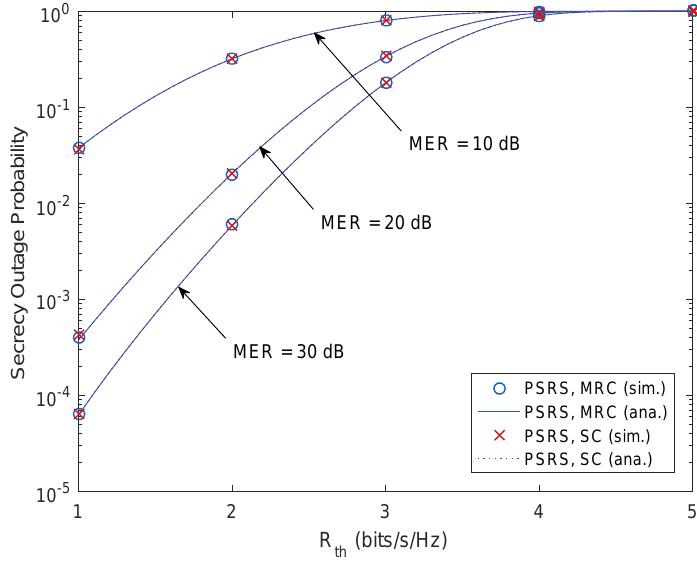
Figure 3. Secrecy outage probability as a function of the secrecy target data rate, R th (bits/s/Hz), with different values of the main-to-eavesdropper ratio (MER), where M = 3, N = 3, d SR = 0.5 and SNR = 10